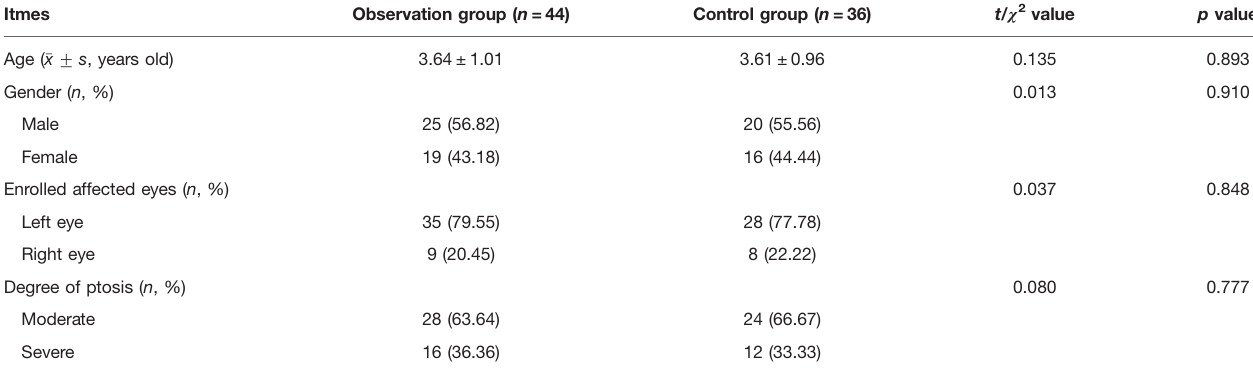
TABLE 1 | Comparison of general conditions of two groups.